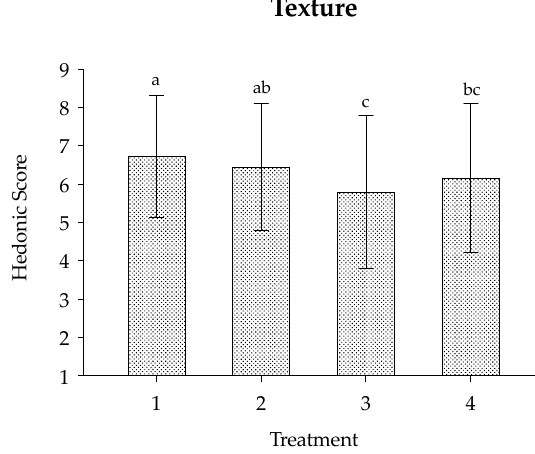
sweet flavour, and thick, yet smooth consistency. Treatment 3 was the least liked sample as it left an aftertaste and its texture was described as sticky and runny. Fermentation 2020 , 6 , x FOR PEER REVIEW Figure 3. Panellists ( n = 111) rated the texture of four probiotic yogurt treatments using a nine-point hedonic scale ranging from 1 (dislike extremely) to 9 (like extremely). A one-way repeated-measures ANOVA and Fisher’s least significant difference test were used to analyse statistically significant differences ( p < 0.05) between mean hedonic scores. Significant differences ( p < 0.05) between treatments are denoted by different lowercase letters ( a–c ) above each bar graph. (Treatment 1 indicates 100% cow milk (control); Treatment 2, 75% cow milk + 25% soymilk; Treatment 3, 50% cow milk + 50% soymilk; Treatment 4, 25% cow milk + 75% soymilk).